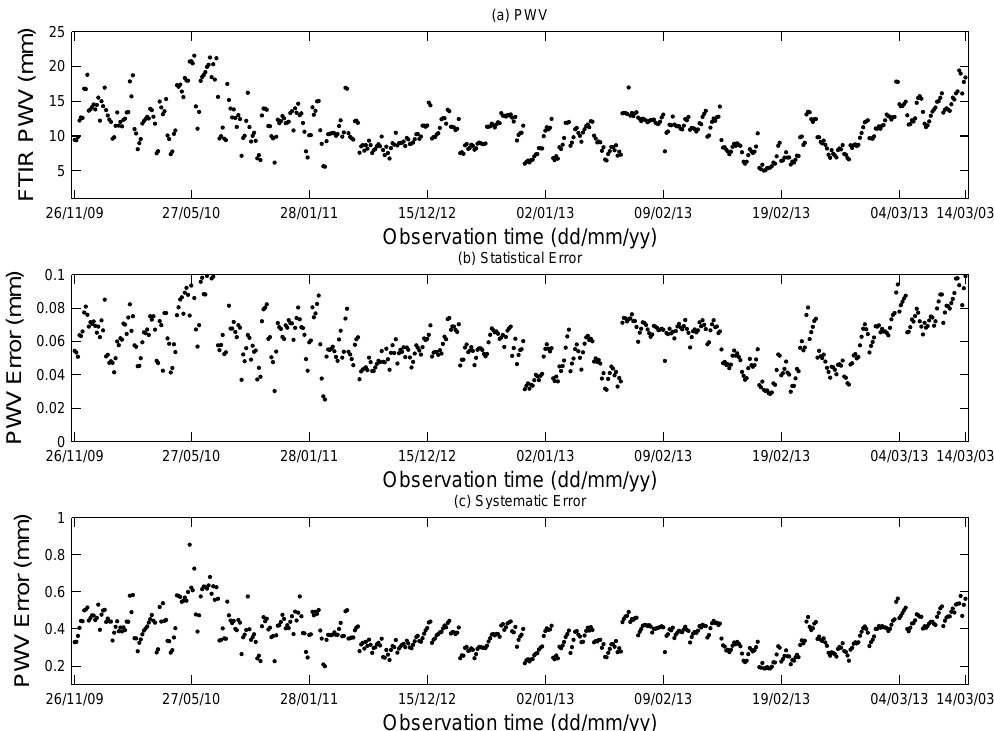
Figure 3. FTIR observations: (a) PWV; (b) statistical error due to random retrieval errors in PWV; and (c) systematic error in